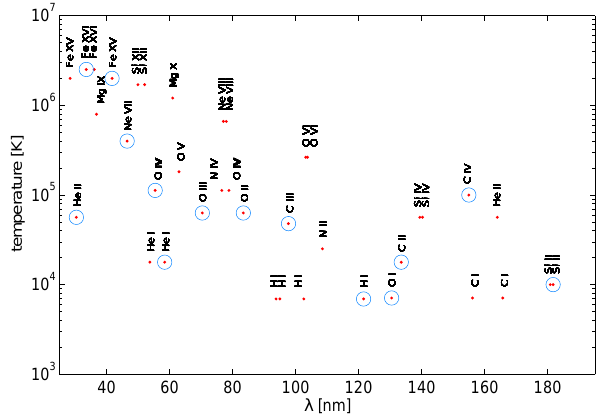
Fig. 8. Wavelength vs. characteristic emission temperature plot of the 38 most intense spectral lines. The 14 selected lines are